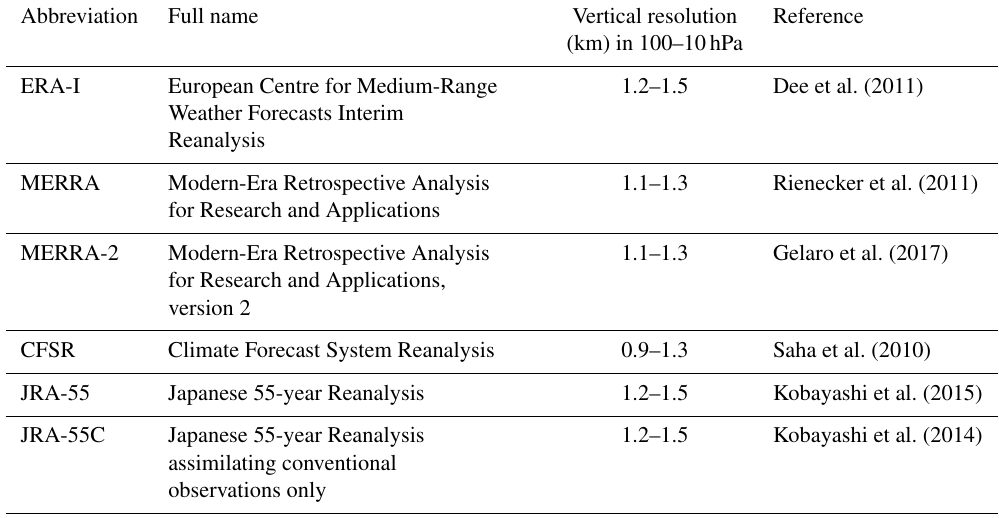
Table 1. Reanalyses used in this